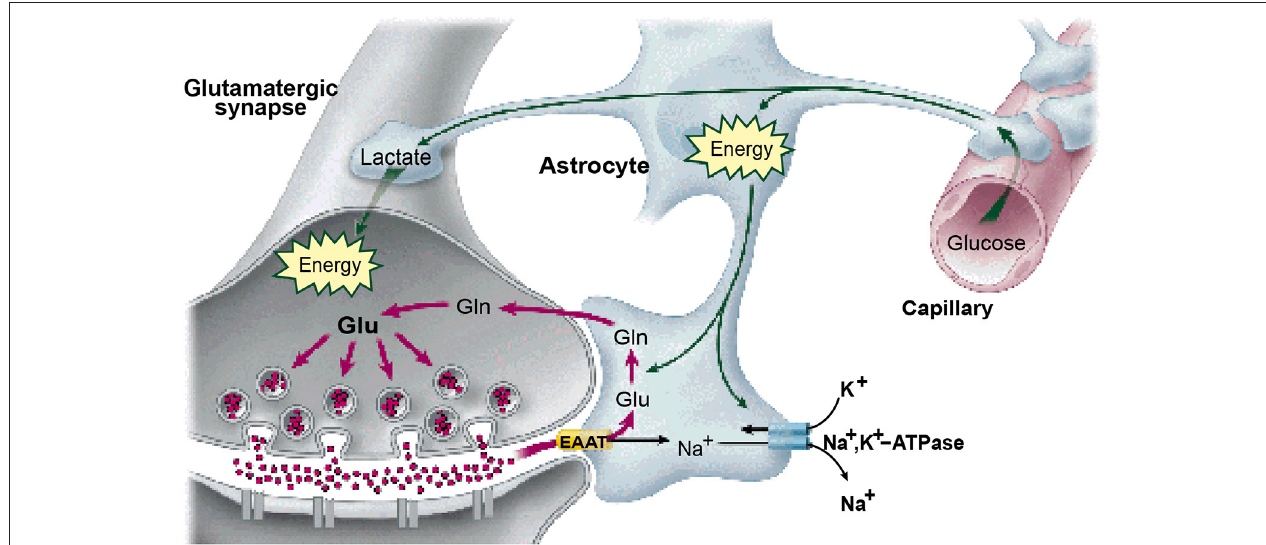
FIGURE 1 | The astrocytes as the substrate for the neurovascular coupling of the neural metabolism. (From Magistretti, 2006, with